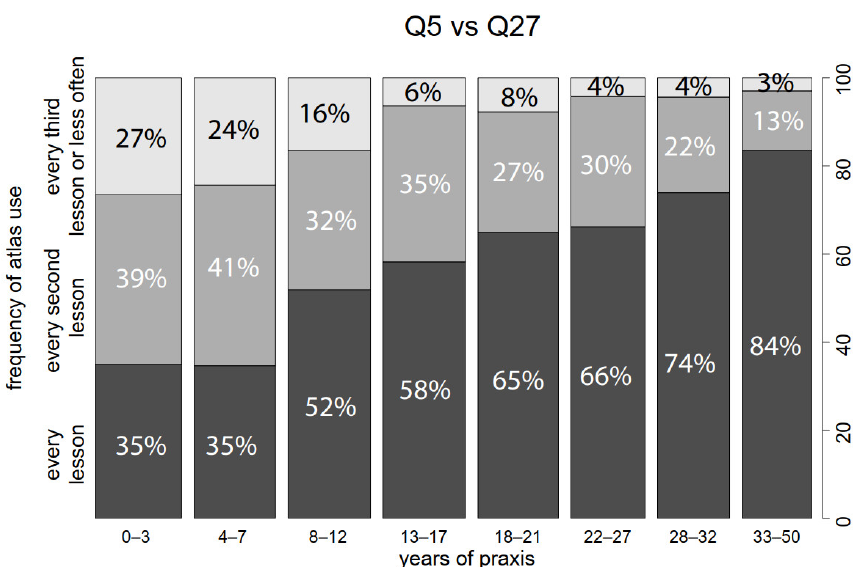
Figure 11. The influence of years of praxis (Q27) on the frequency of atlas use (Q5).